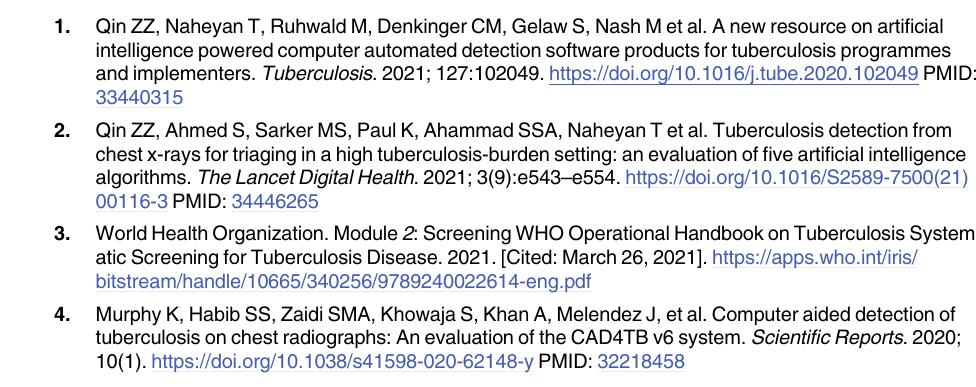
S1 Table. Comparison of the AUCs of two versions of CAD4TB and qXR. S2 Table. How threshold score impacts sensitivity and number of diagnostic tests saved for different product versions. S3 Table. The AUCs of CAD product versions in sub-analyses that showed differences in